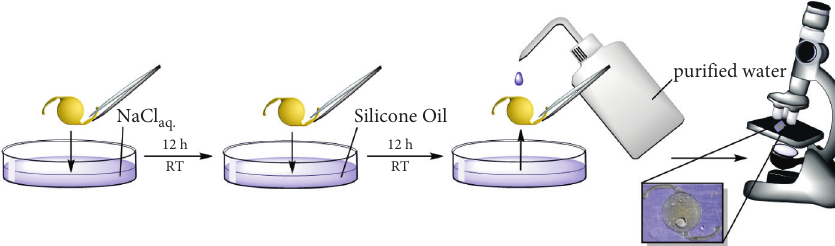
Figure 2: Investigation process of the silicone oil adhesion procedure.